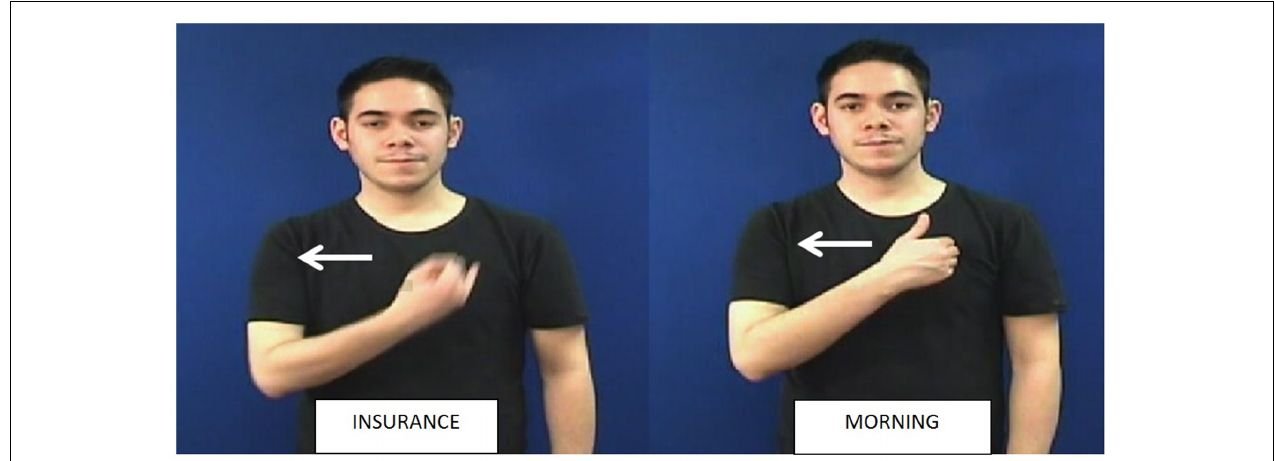
FIGURE 1 | Minimal pairs in British Sign Language (BSL). Both signs share the same location [torso] and movement [left-right] but INSURANCE is articulated with the handshape and morning with the handshape